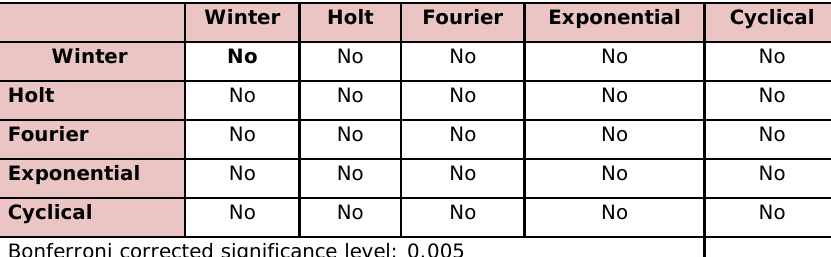
Table 5. “Significant differences for inventory